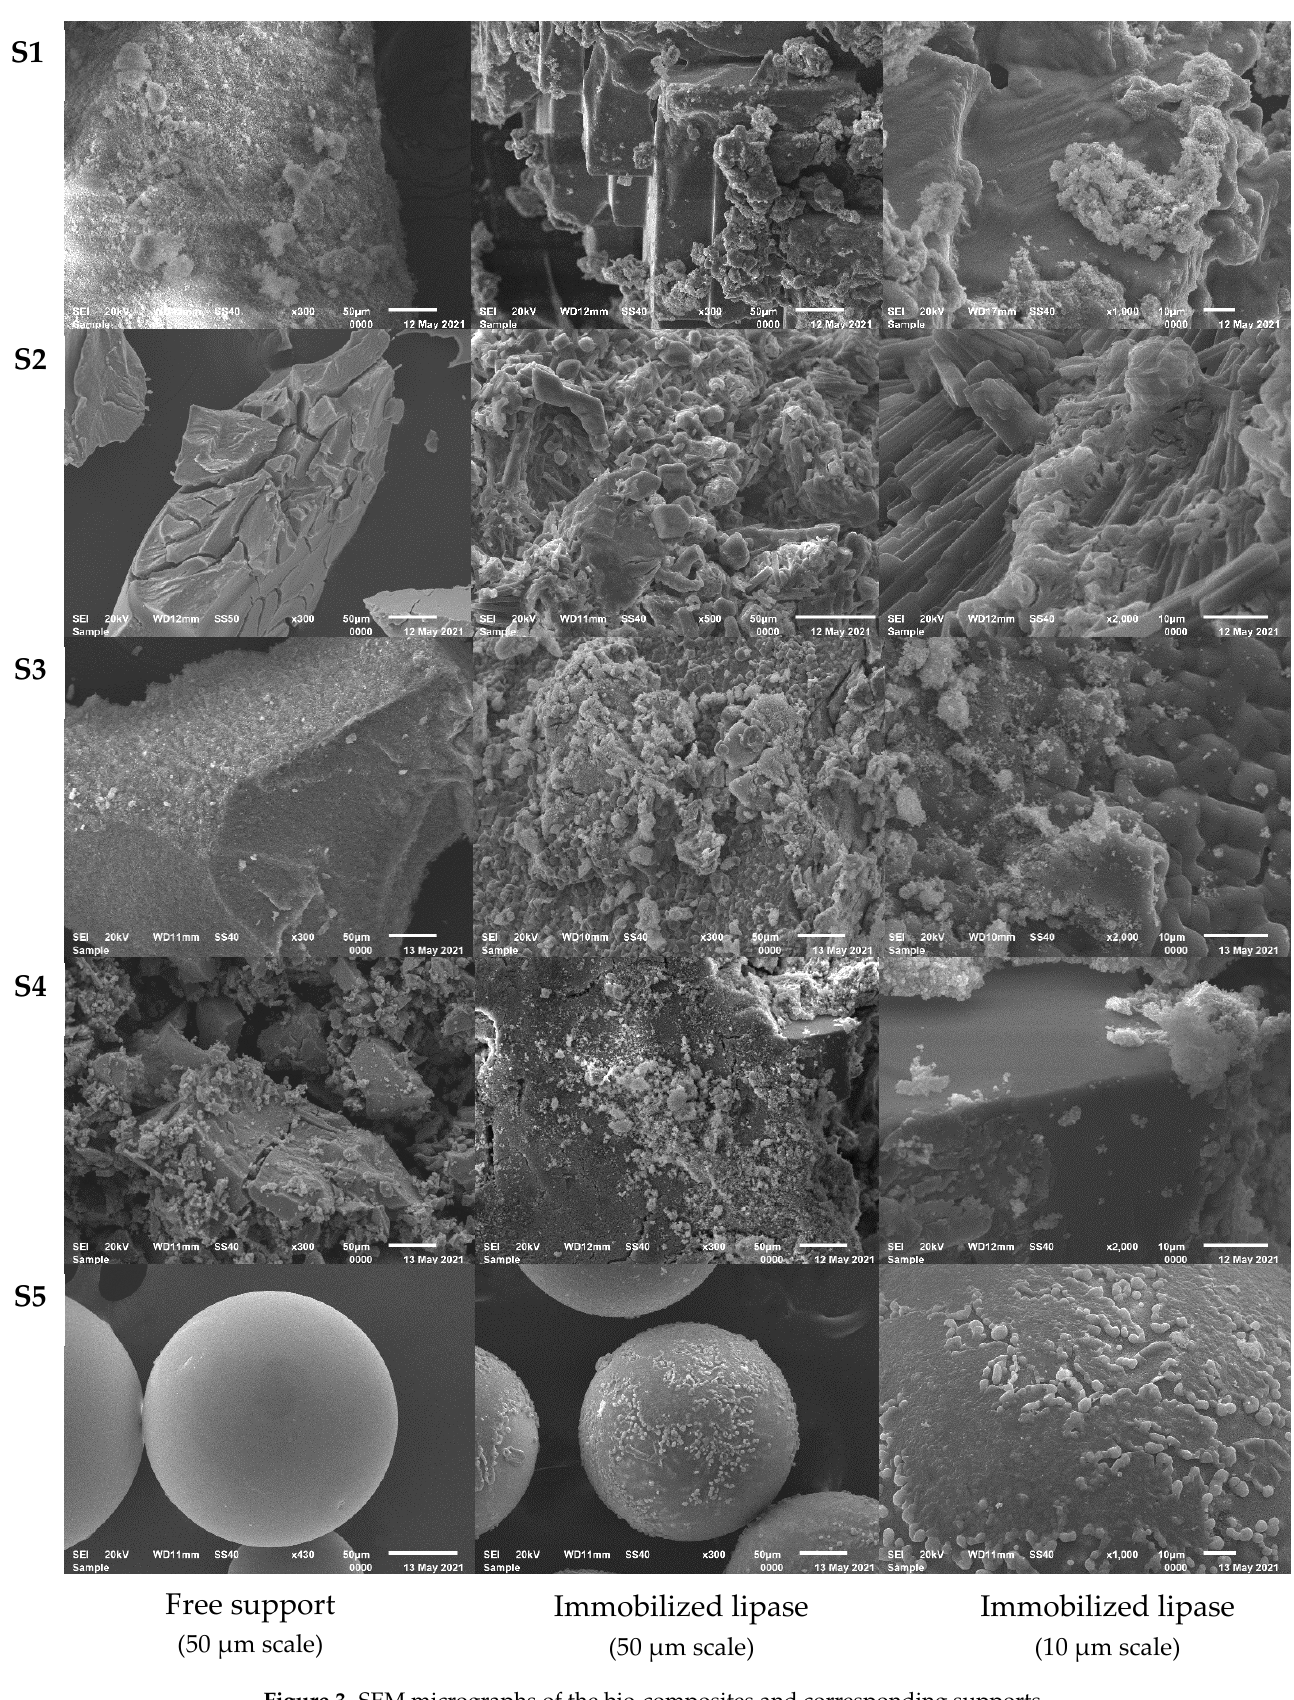
Figure 3. SEM micrographs of the bio-composites and corresponding supports.